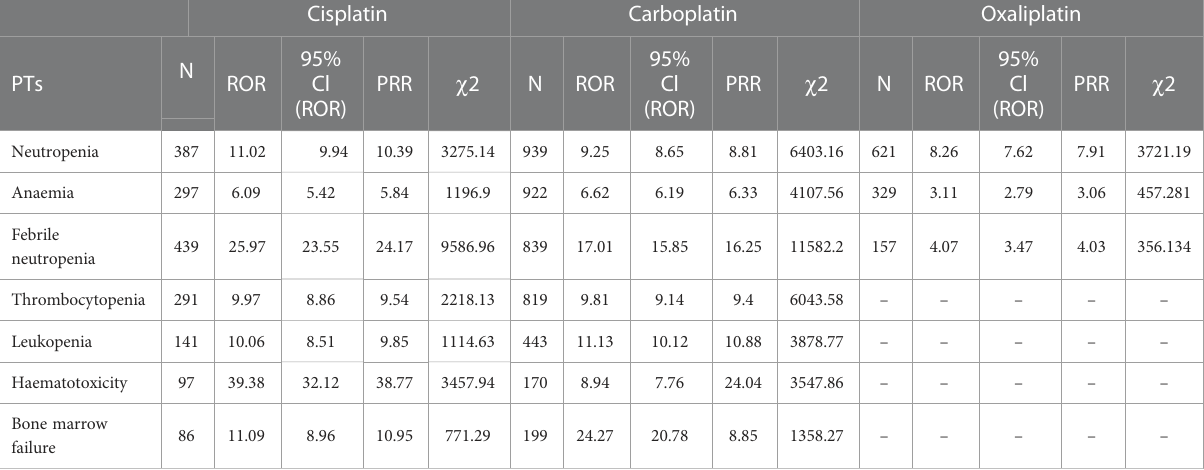
TABLE 5 Blood and lymphatic system disorder-related adverse events of Cisplatin, Carboplatin and Oxaliplatin.